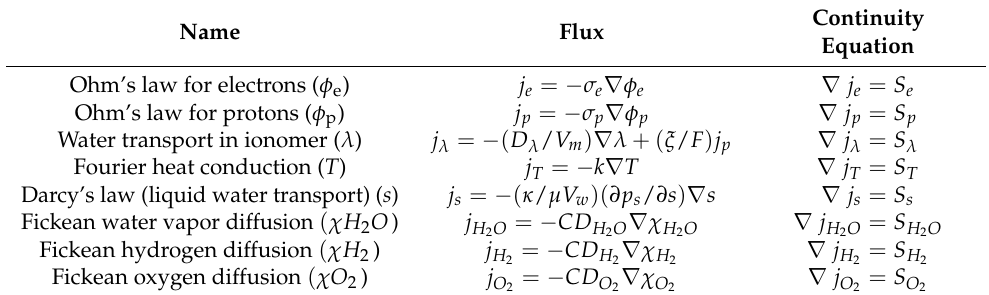
Table 1. Governing equations.